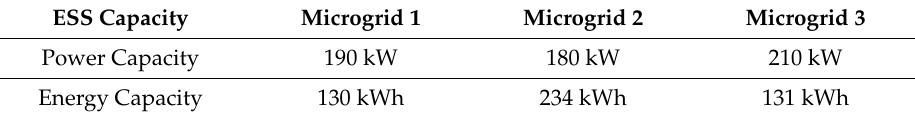
Figure 10. Microgrid original power (yellow line), expected power (grey line) and ESS power (blue line) curve based on Objective 2. ( a ) Results of independent microgrid 1. ( b ) Results of independent microgrid 2. ( c ) Results of independent microgrid 3. ( d ) Results of interconnected microgrid 1. ( e ) Results of interconnected microgrid 2. ( f ) Results of interconnected microgrid 3. Table 4. ESS capacity of independent microgrid scheme with Objective 2.